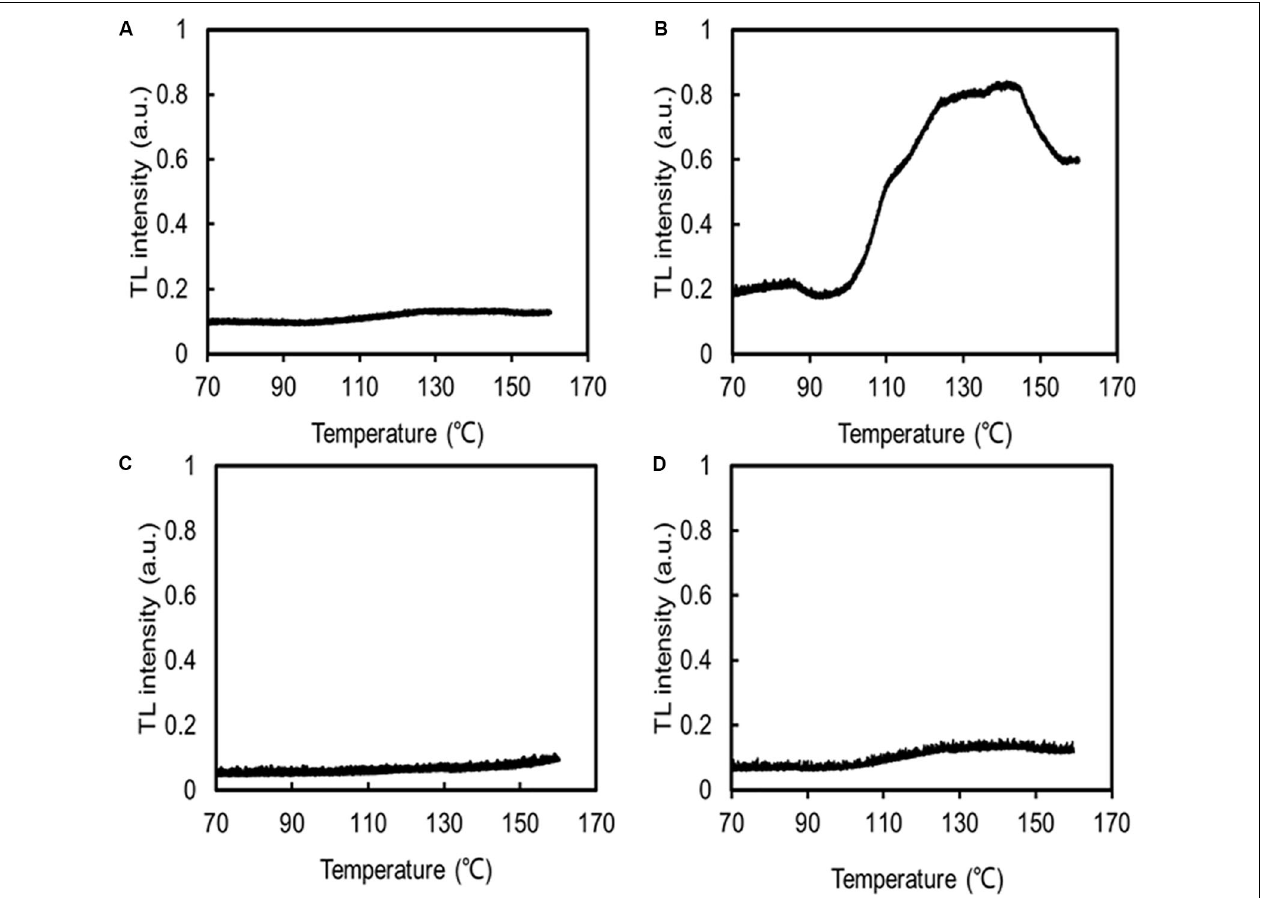
FIGURE 8 | HTL glow curves indicating lipid peroxidation. The same concentrations of C. nivalis and C. reinhardtii were measured. Samples were heated from 10 to 160 ◦ C, at a rate of 0.1 ◦ C s − 1 , and their emissions were subsequently recorded. N 2 gas was flushed through the samples to dry them and prevent any oxidation induced by high temperatures, a.u. arbitrary units. (A) C. reinhardtii at 22 ◦ C. (B) C. reinhardtii at 4 ◦ C. (C) C. nivalis at 22 ◦ C. (D) C. nivalis at 4 ◦